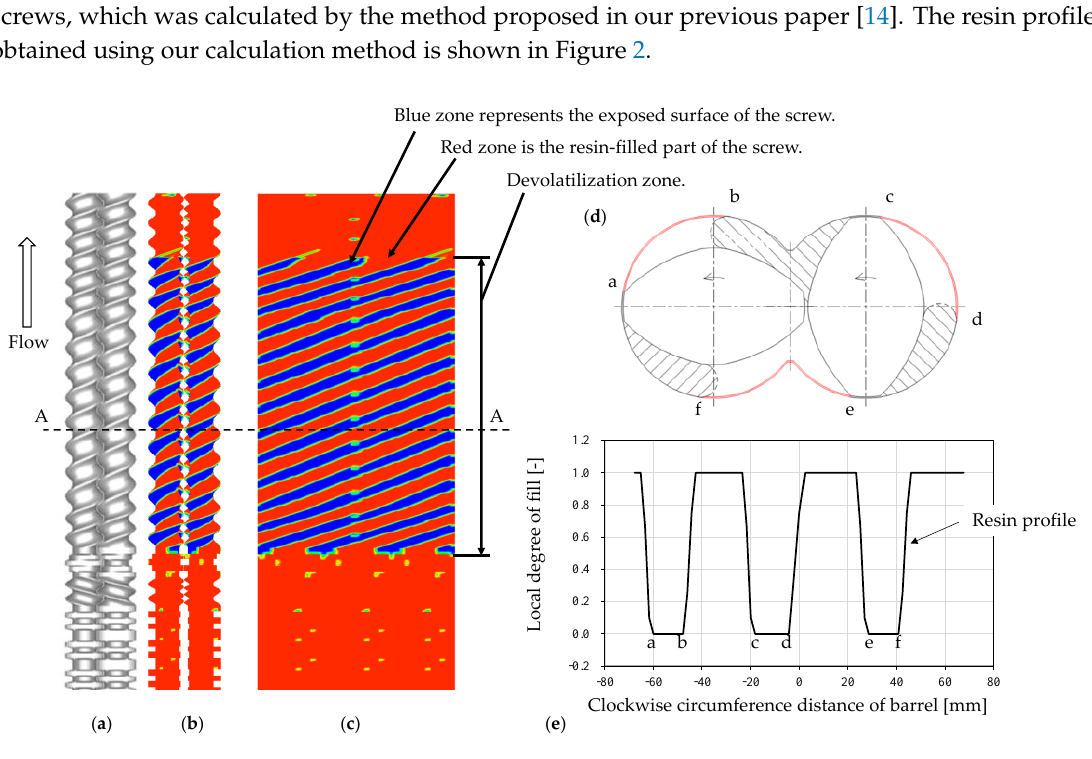
Figure 2. Devolatilization calculation section ( z e – z s ) and the exposed surface boundary length in a twin-screw extruder. ( a ) Screw configuration. ( b ) Resin distribution: red and blue indicate the local degree of fill 1 and zero, respectively. ( c ) Resin distribution on unwrapped screw geometry. ( d ) Cross-sectional view of screw, barrel, and resin in the starved zone. ( e ) Local degree of fill distribution as a function of clockwise circumference distance of the barrel.